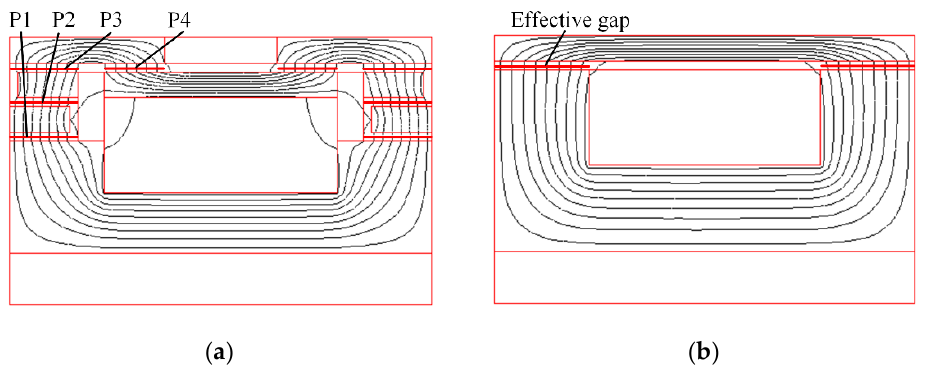
Figure 6. Comparison of the magnetic flux lines: ( a ) Proposed MR damper; ( b ) Traditional MR damper.